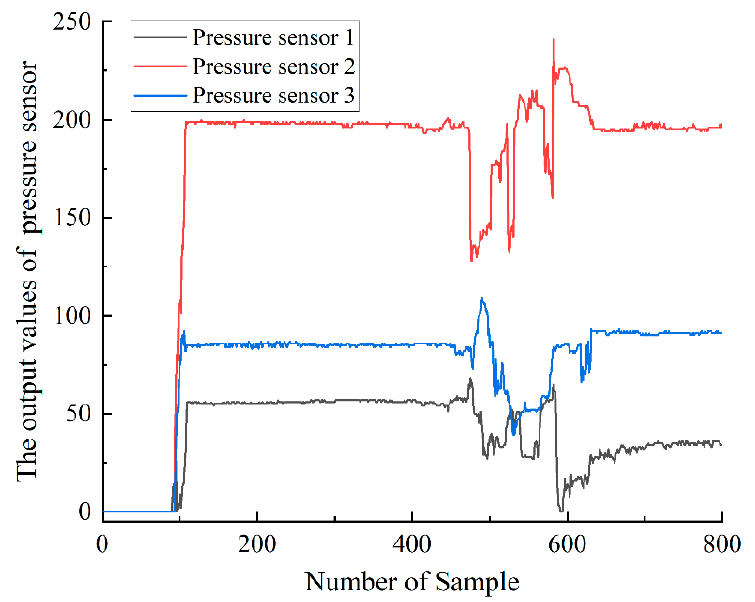
Figure 12. The output values of three pressure